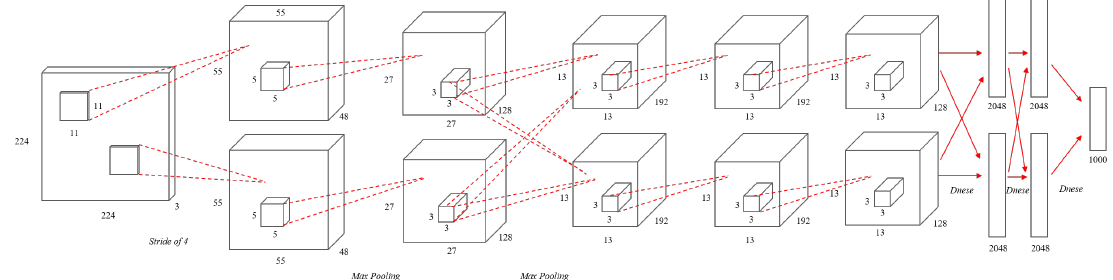
Figure 1. An illustration of the architecture of AlexNet.